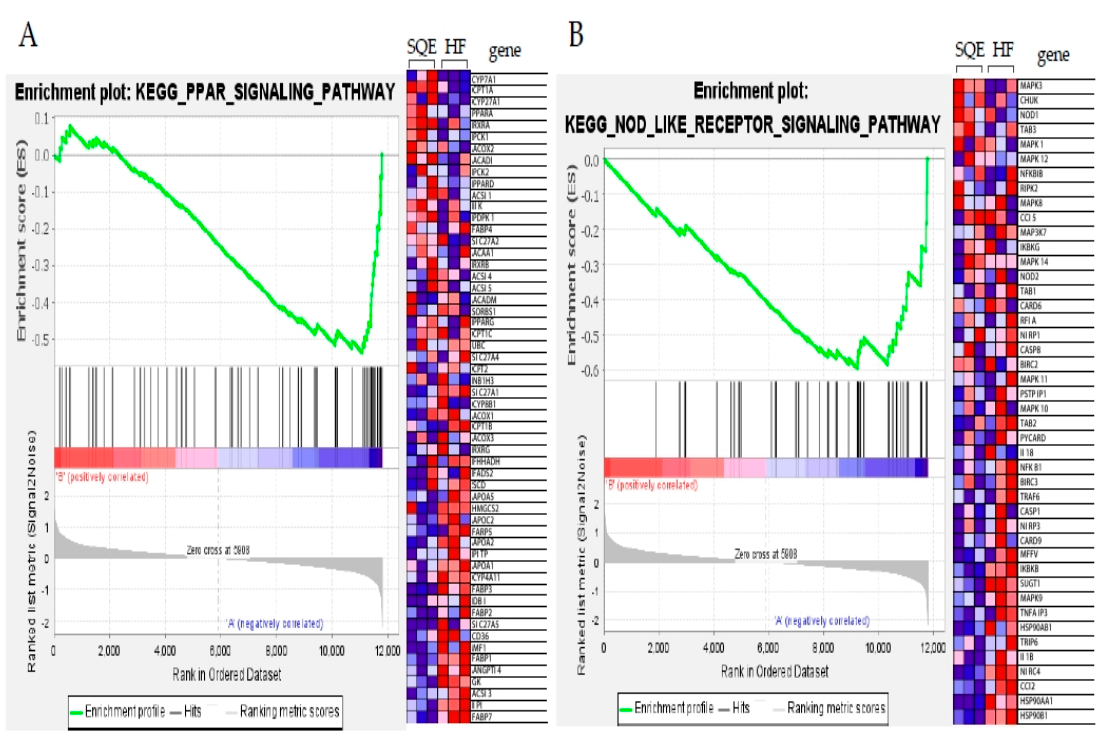
Figure 9. Gene set enrichment analysis (GSEA) plots depict the differentially expressed genes (DEGs) identified between the HF and SQE groups. ( A ) PPAR signaling pathway categories, ( B ) NOD-like receptor signaling pathway. HF, 60% fructose diet; SQE, 60% fructose diet with SQE (500 mg/kg of BW) in drinking water. HF, high-fructose-diet-fed rats; SQE, the high-fructose-diet-fed rats supplemented with S. quelpaertensis leaf extract.